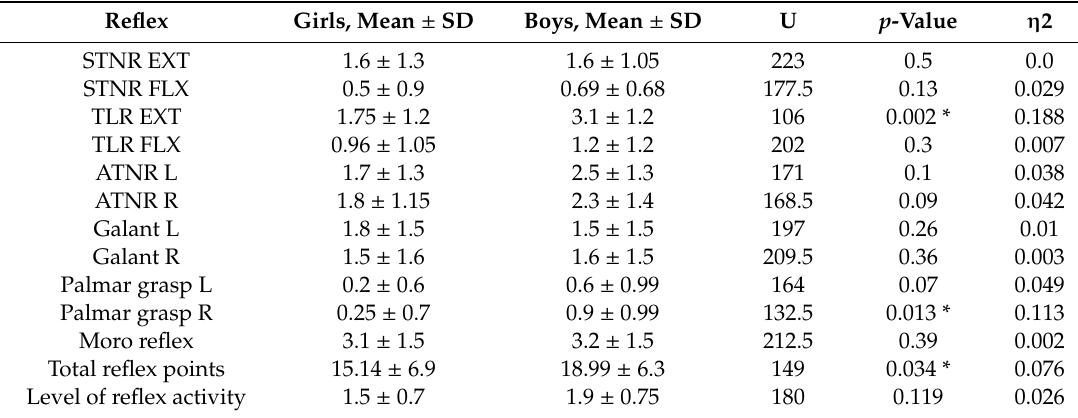
Table 5. Di ff erences between girls and boys in the results of the examination of reflexes.